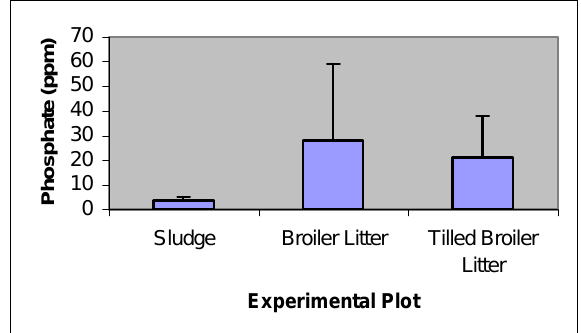
Figure 2: Phosphate levels (ppm) detected within the experimental plots.